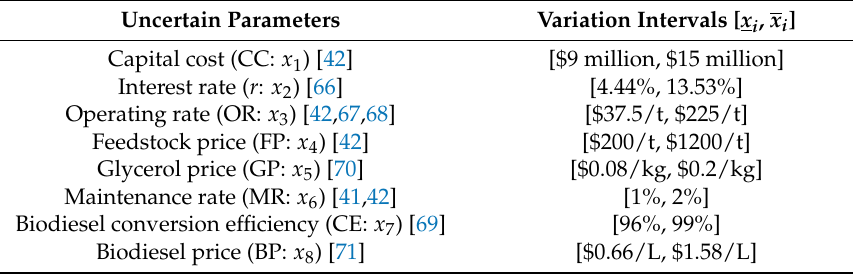
Table 1. Variation intervals of uncertain parameters for biodiesel